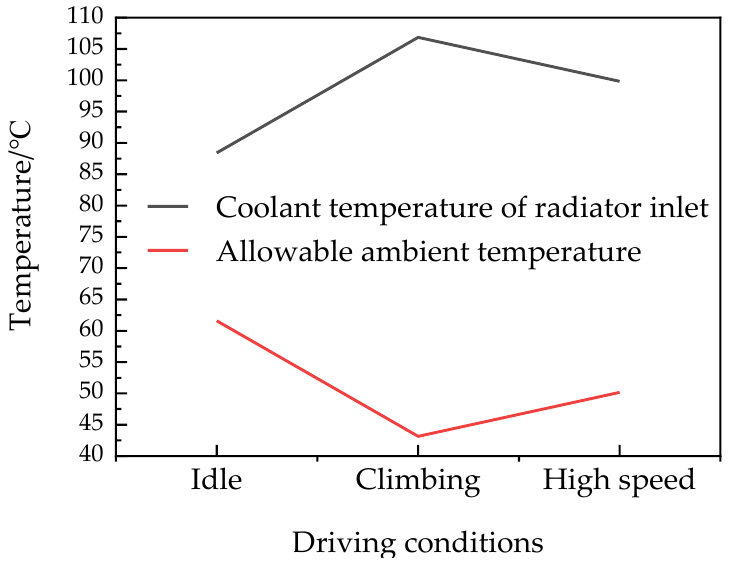
Figure 4 . Comparisons of coolant temperature of radiator inlet and allowable ambient temperature under different working conditions .